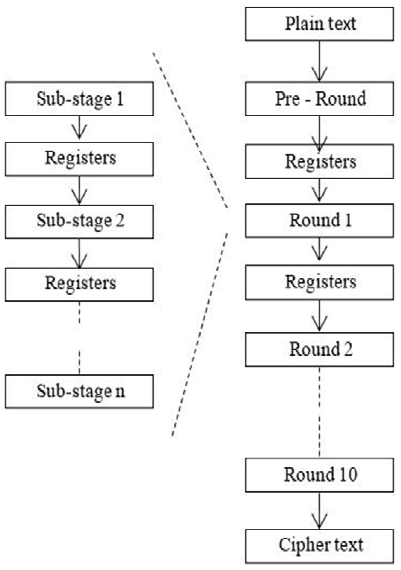
Figure 2. Illustration of the subpipelining architecture.